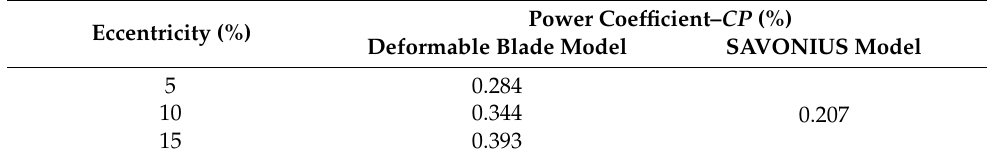
Table 8. Power coefficient values for the deformable blade rotor with different eccentricity values [89]. Power Coefficient– CP Eccentricity (%)